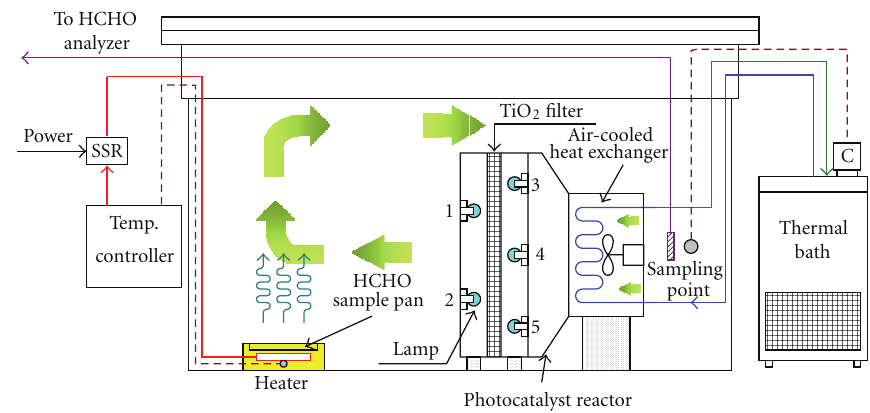
Figure 5: The installation of photocatalytic circulation